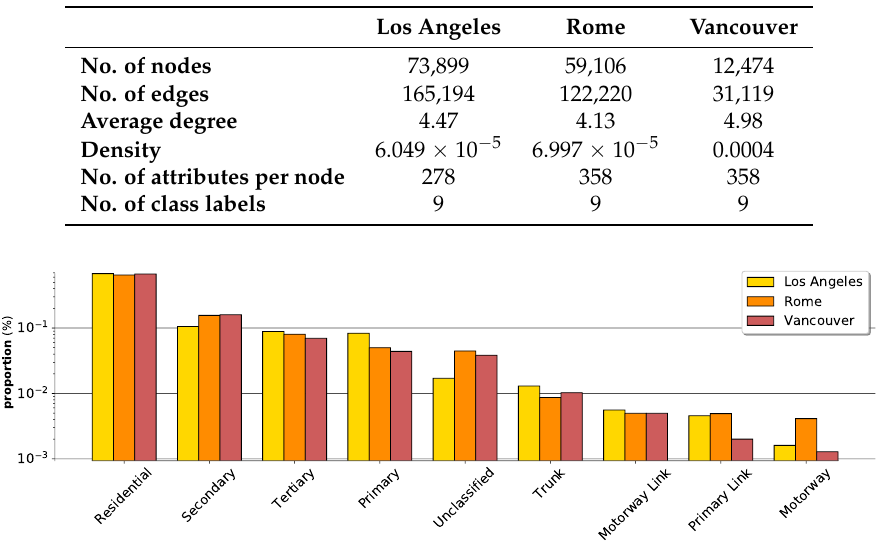
Figure 4. Distribution of street labels across the different cities. We see high variance between the different classes of streets. The y -axis is the proportion of each street class plotted on the log